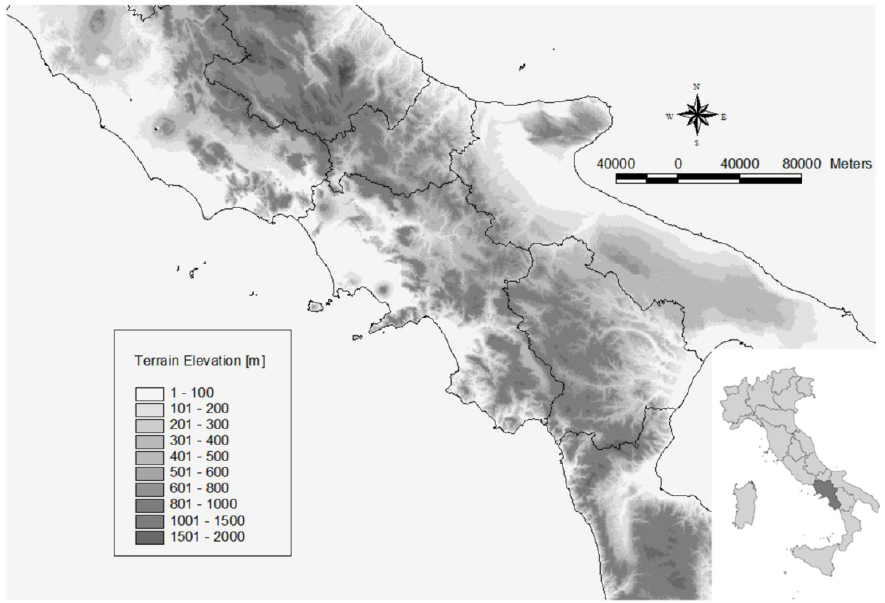
Figure 1. Location of Campania region with DEM.